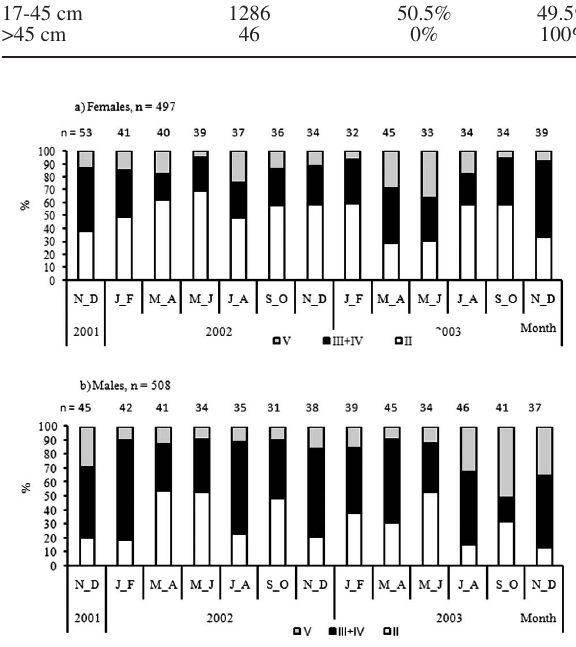
Fig . 3. – Bimonthly percentages of M. merluccius in different ma- turity stages during the sampling period. II, maturing and recovery; III+IV, advanced maturing + spawning; V, post-spawning. (a) Fe- males; (b) Males.